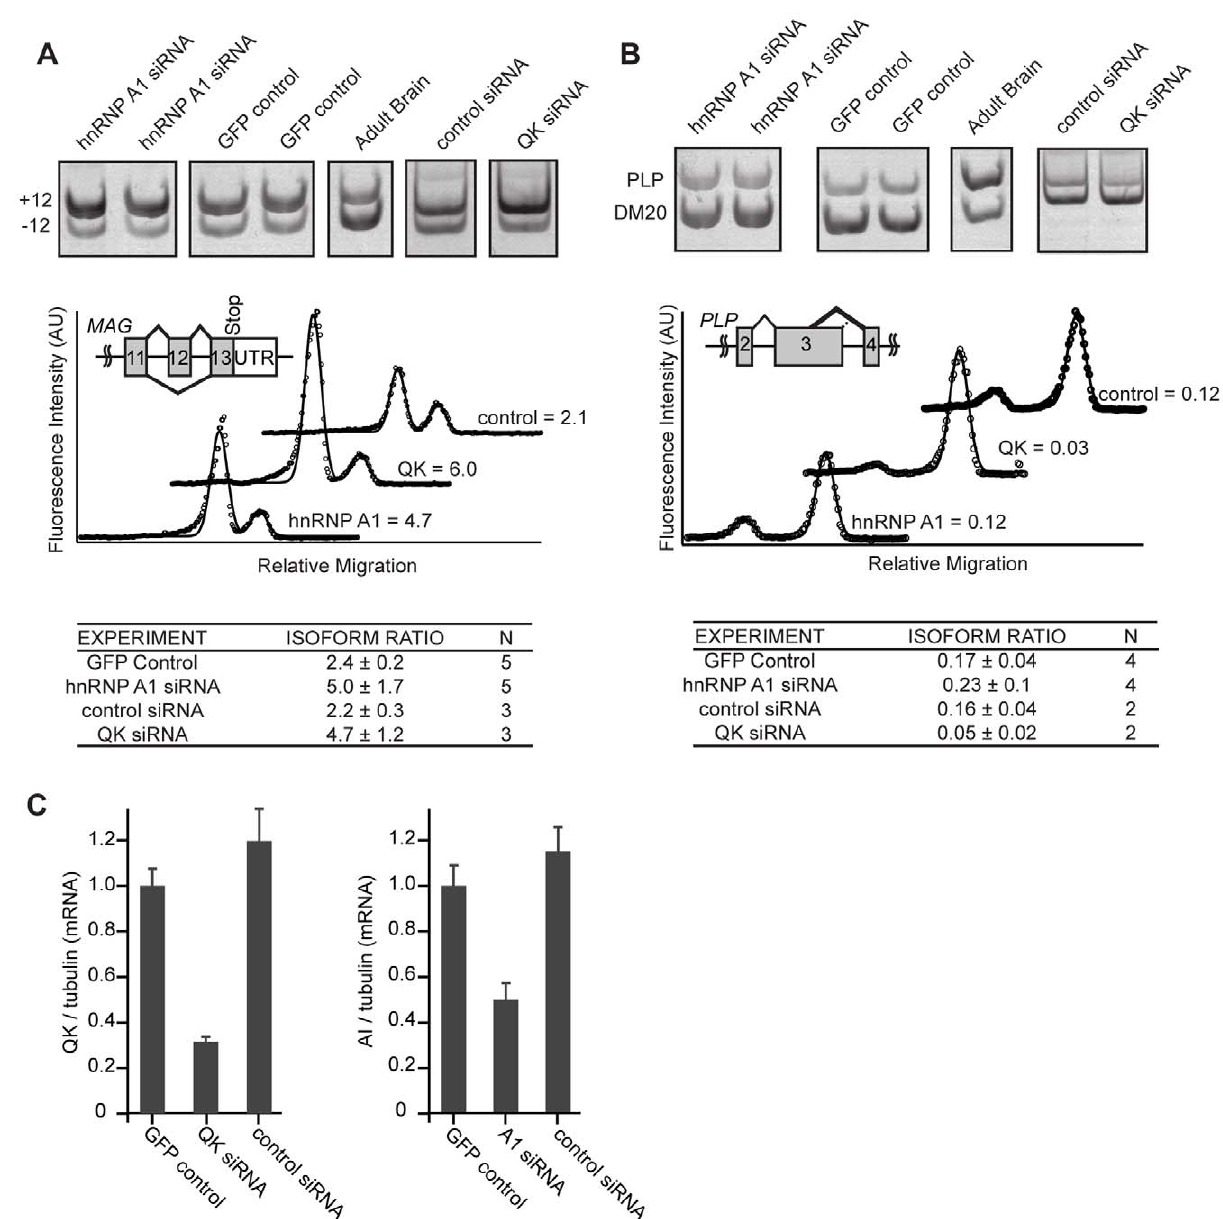
Figure 5. hnRNP A1 co-regulates Mag alternative splicing. (A) RNA was prepared from cells that had been transiently transfected with Hnrnpa1 or QK siRNA and selected with G418. RNA produced from CG-4 cells transfected with a control selection plasmid was analyzed alongside as a control. Isoforms of Mag containing or lacking exon 12 were amplified by RT-PCR using fluorescent primers. Products were separated in 5% acrylamide gels. Gels were scanned and the relative isoform ratio was calculated from the intensity profile of the lane using ImageGauge. Representative intensity profiles are presented below representative gel images. Data and standard deviations were calculated from 3 (control siRNA and Qk siRNA) or 5 (GFP control and Hnrnpa1 siRNA) independent transfections. An increase in expression of the longer isoform was detected upon transfection of both Hnrnpa1 and Qk siRNA. (B) Plp1 and Dm20 isoform ratios were analyzed as described above for Mag . A decease in expression of the upper isoform was detected when Qk siRNA was transfected but not when Hnrnpa1 siRNA was transfected. (C) Qk and Hnrnpa1 knockdown were confirmed by qRT-PCR. doi:10.1371/journal.pgen.1001269.g005 upregulated exons, including the hnRNP A1 motif TAGGT (fold their frequency in all annotated rat exons (Table S2). To assess enrichment FE =1.54, p= 5 6 10 2 3 ) and the QSBE motif ACUAA statistical significance, we also determined the 5mer frequency (FE =1.54, p =8 6 10 2 7 , Figure 8A). The A1 motif is similar to an from ten sets of an equivalent number of randomly selected exons. exonic splicing silencer motif identified by Burge and co-workers a greater than 1.5 fold enrichment and a p-value of less than 0.05 [46]. There are 149 significant enriched 5mers in QK downreg- when compared to the randomly selected exon set (Table S2). We ulated exons. These include the hnRNP A1 motif TAGGT (FE =1.94, p= 3 6 10 2 3 ), but not the QSBE ACUAA motif. While